Question: Briefly state, in one sentence, what is plotted here.
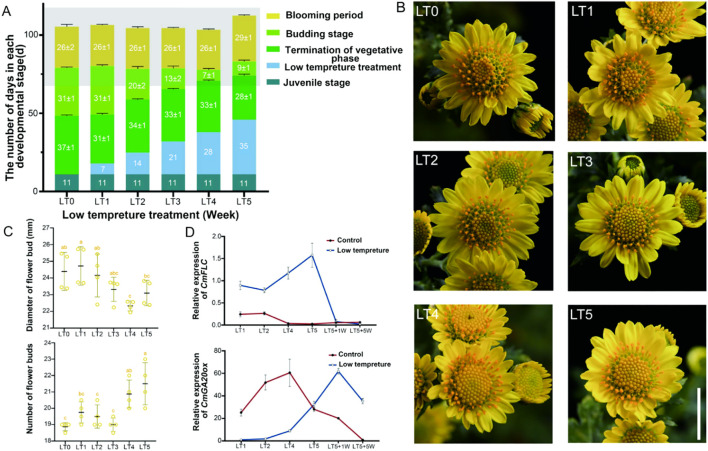
Answer: Flowering phenotypes in ‘xiaokuixiang’ following low-temperature treatments of varying durations. (A) Growth periods under different treatment with the shaded area indicating the start of short-day conditions. (B) Inflorescence opening morphology. scale bar = 1 cm. (C) Inflorescences diameter and number. (D) Expression of flowering-related genes. LT, low temperature.